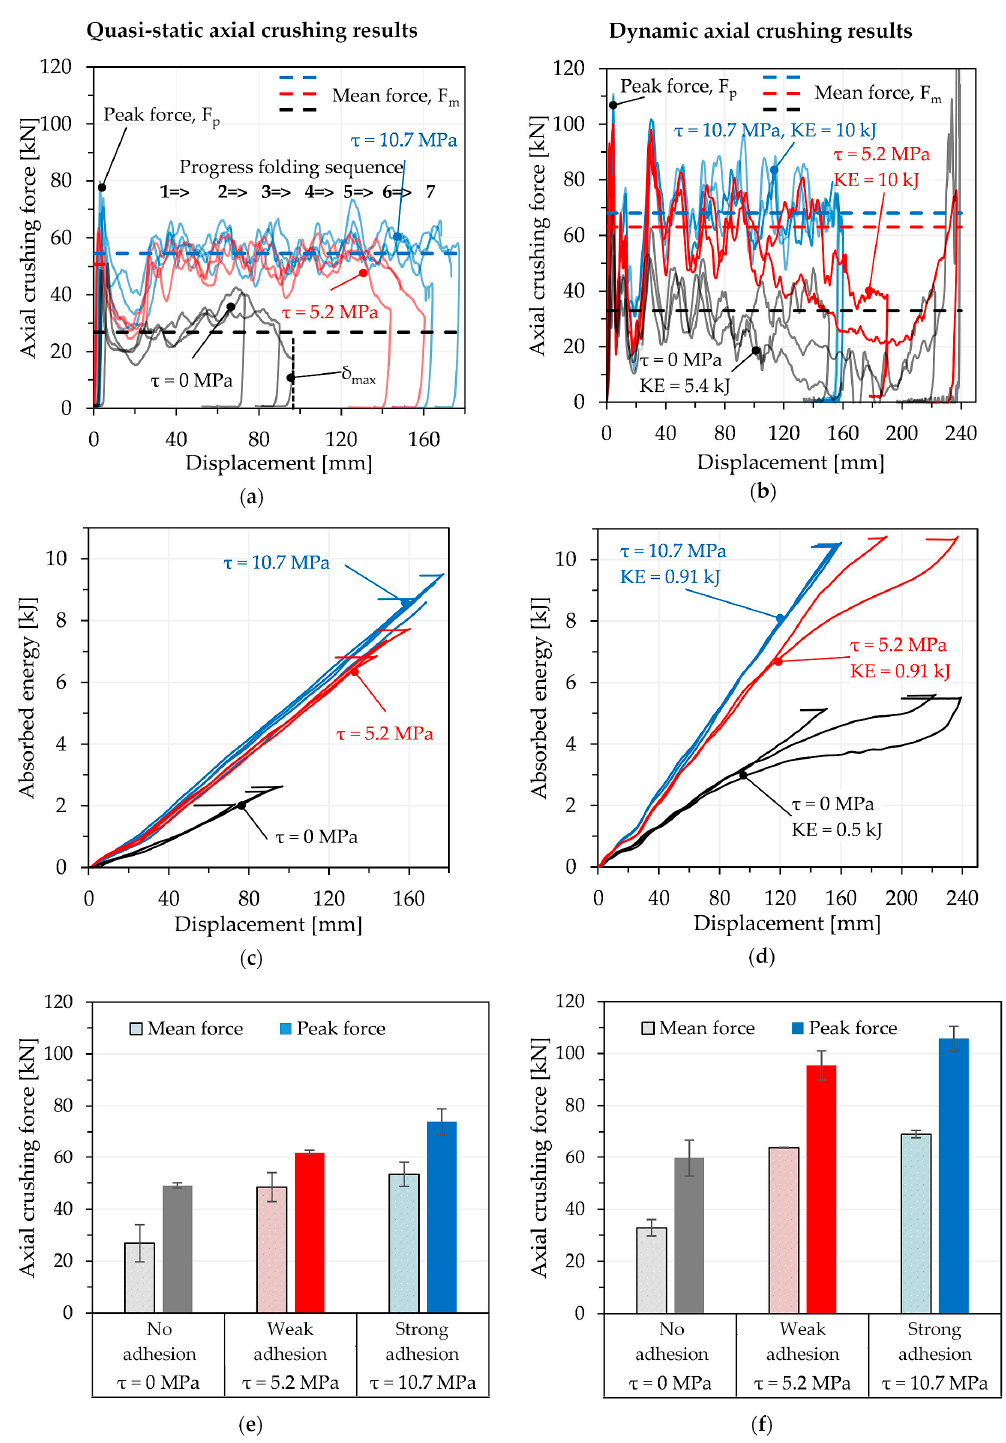
Figure 5. Axial crushing test results of the double-hat crashboxes in terms of the quasi-static ( a , c ) and the highly dynamic ( b , d ) loading rates as well as a summary of the forming force results in ( e , f ).